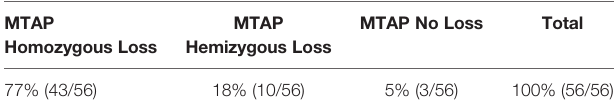
TABLE 4A | Homozygous, hemizygous and no loss of methylthioadenosine phosphorylase (MTAP) detected by fl uorescence in situ hybridization (FISH) in malignant pleural mesothelioma (MPM) cases.